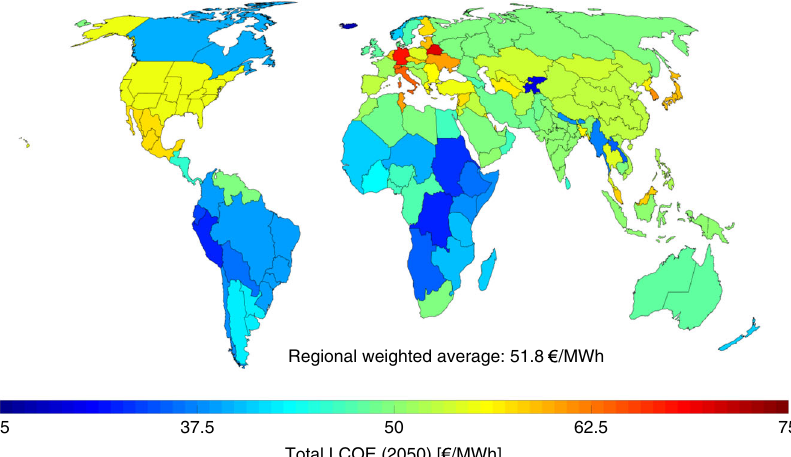
Fig. 2 Levelized cost of electricity for 100% renewable electricity systems in 2050. Country average numbers are presented. Numbers are calculated based on the generation mix for 2050 and fi nancial and technical assumptions for all electricity system components. For countries divided in several regions, levelized cost of electricity is calculated as weighted